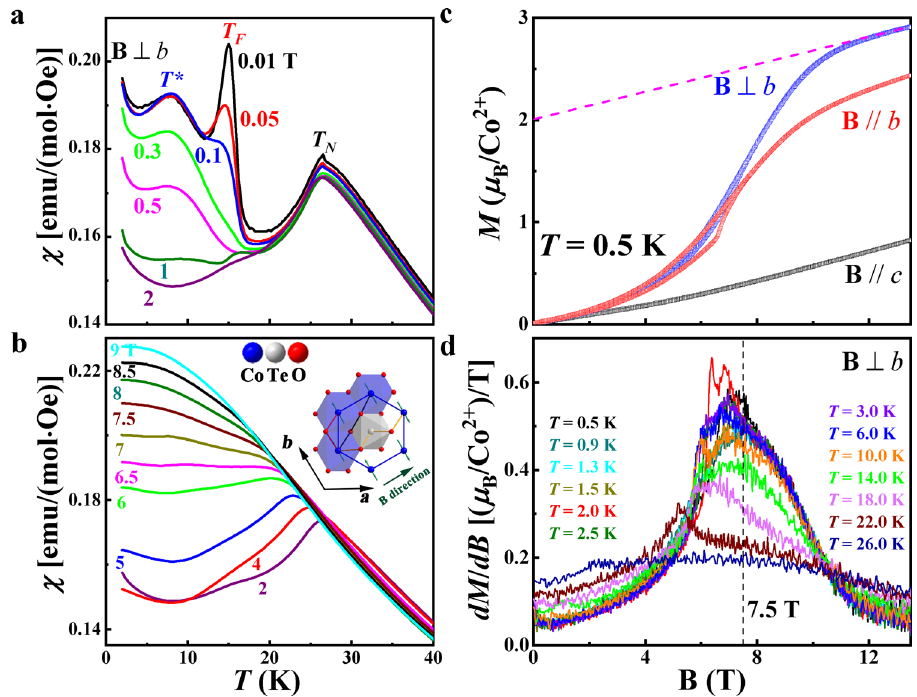
Fig. 2 Magnetic susceptibility of Na 2 Co 2 TeO 6 for B ⊥ b -axis. a , b Temperature dependence of susceptibility χ ( T ) in NCTO measured at various magnetic fi elds. The inset of Fig. 2b shows the honeycomb lattices of Co viewed along the c -axis. The cartoon shows the moments to be in the basal plane and parallel to the b -axis 40, 41 , and the TeO 6 octahedra sit at the center of each honeycomb unit. The fi rst NN ferromagnetic (FM) interaction J originated from a collaboration between Co – O – Co (red bond) superexchange interactions and Co – Co (blue bond) direct exchange interactions. The second NN J 2 has multiple superexchange interaction pathways, which may lead to a wide range of variations, mainly determined by J and J 3 . The third NN AFM interaction J 3 arises from the existence of the Te atom in the center of the honeycomb lattice, which leads to the unique superexchange interaction pathway Co – O – Te – O – Co (golden bond). The olive arrow refers to the direction of applied magnetic fi eld B in the magnetization. c The isothermal magnetization M ( B ) with the applied magnetic fi eld B ⊥ b , B // b , and B // c -axis at 0.5 K, respectively. The dashed line indicates the Van-Vleck paramagnetic background. d The differential isothermal magnetization as functions of fi elds dM / dB vs. B at different temperatures with B ⊥ b .